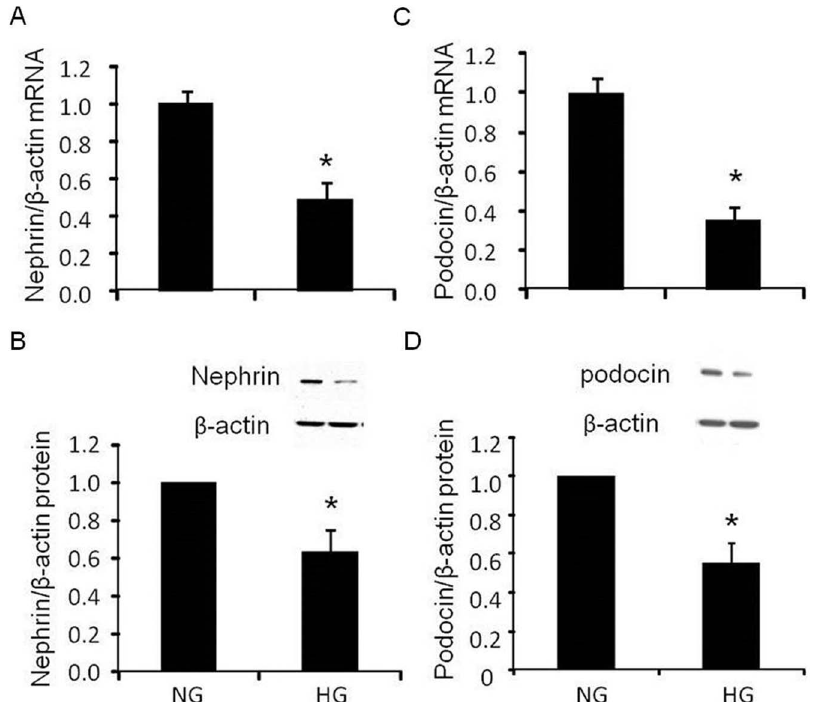
Figure 2. Effect of high glucose on nephrin and podocin expression in podocytes. A. Real time PCR analysis of nephrin mRNA expression (n=5); B. Western blot analysis of nephrin protein expression (n=6); C. Real time PCR analysis of Podocin mRNA expression (n=5); D. Western blot analysis of Podocin protein expression (n=4). Normal glucose, 5 mM D-glucose (NG); high glucose, 25 mM D-glucose (HG). Data presented as mean 6 SEM, * p , 0.05 vs NG doi:10.1371/journal.pone.0089233.g002 (Fig 6A, p , 0.05) and protein by 61% (Fig 6B, p , 0.01), b -catenin mRNA by 46% (Fig 6C, p , 0.01) and protein by 33% (Fig 6D, p , 0.05), and snail mRNA by 34% (Fig 6E, p , 0.01) and protein by 49% (Fig 6F, p , 0.05) in high glucose treated cells.